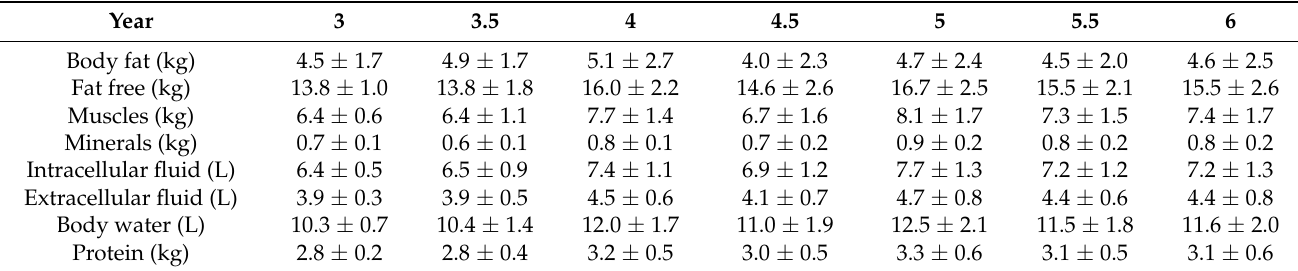
Table 5. Body composition of boys aged 3~6 ( X ± SD, n =